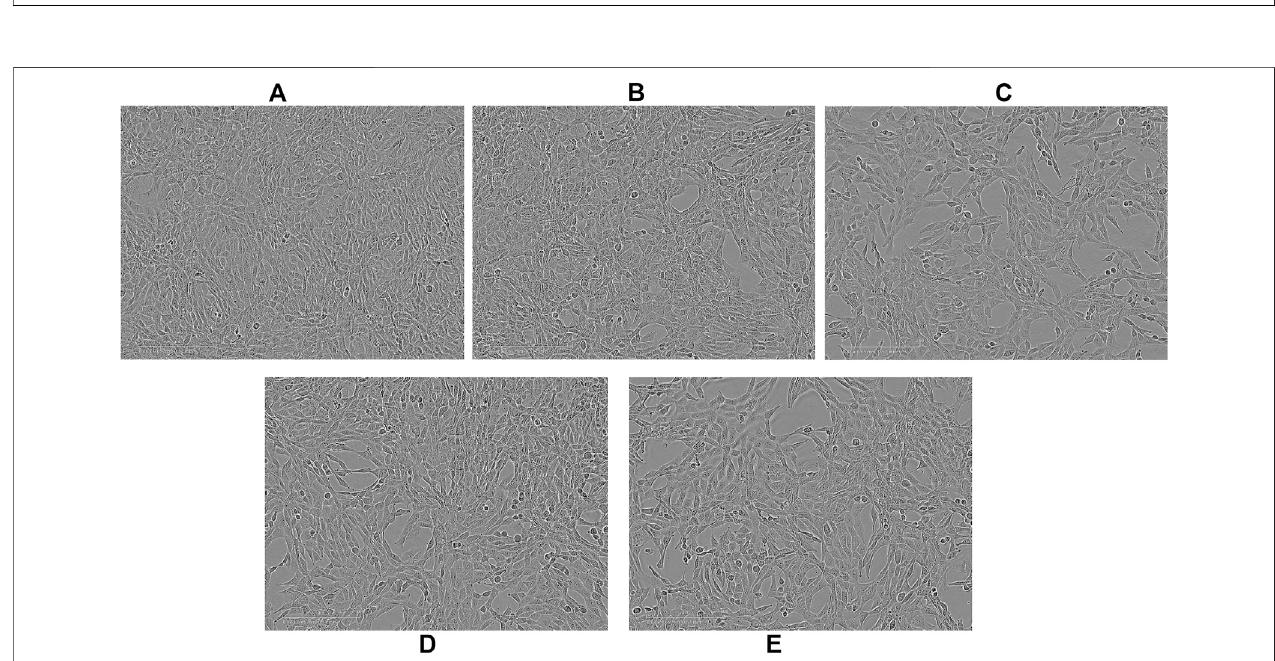
FIGURE 5 | Representative images observed with an optical microscope of NIH3T3 cells after 96 h of treatment. Controls (A) ; ssAPT 25 µM (B) ; APTSAP 20 nM (C) ; APTSAPKQ 20 nM (D) ; pBlue_SAP 20 nM (E) .